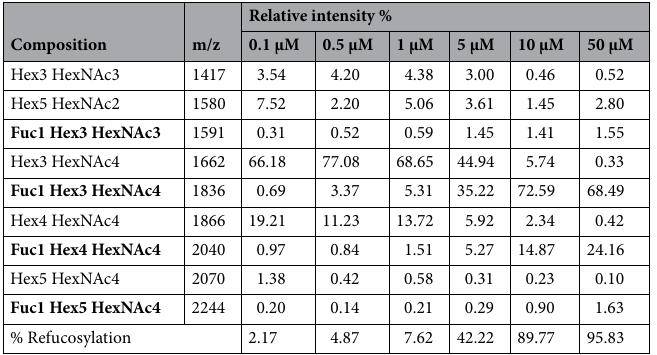
Table 1. List of assigned peaks of refucosylated Remab6 N-glycans from MALDI-TOF–MS analysis. Amount of L-fucose indicated in μM. Fucosylated glycans noted in bold. Raw mass spectrometry data provided in Supplementary Table S1.